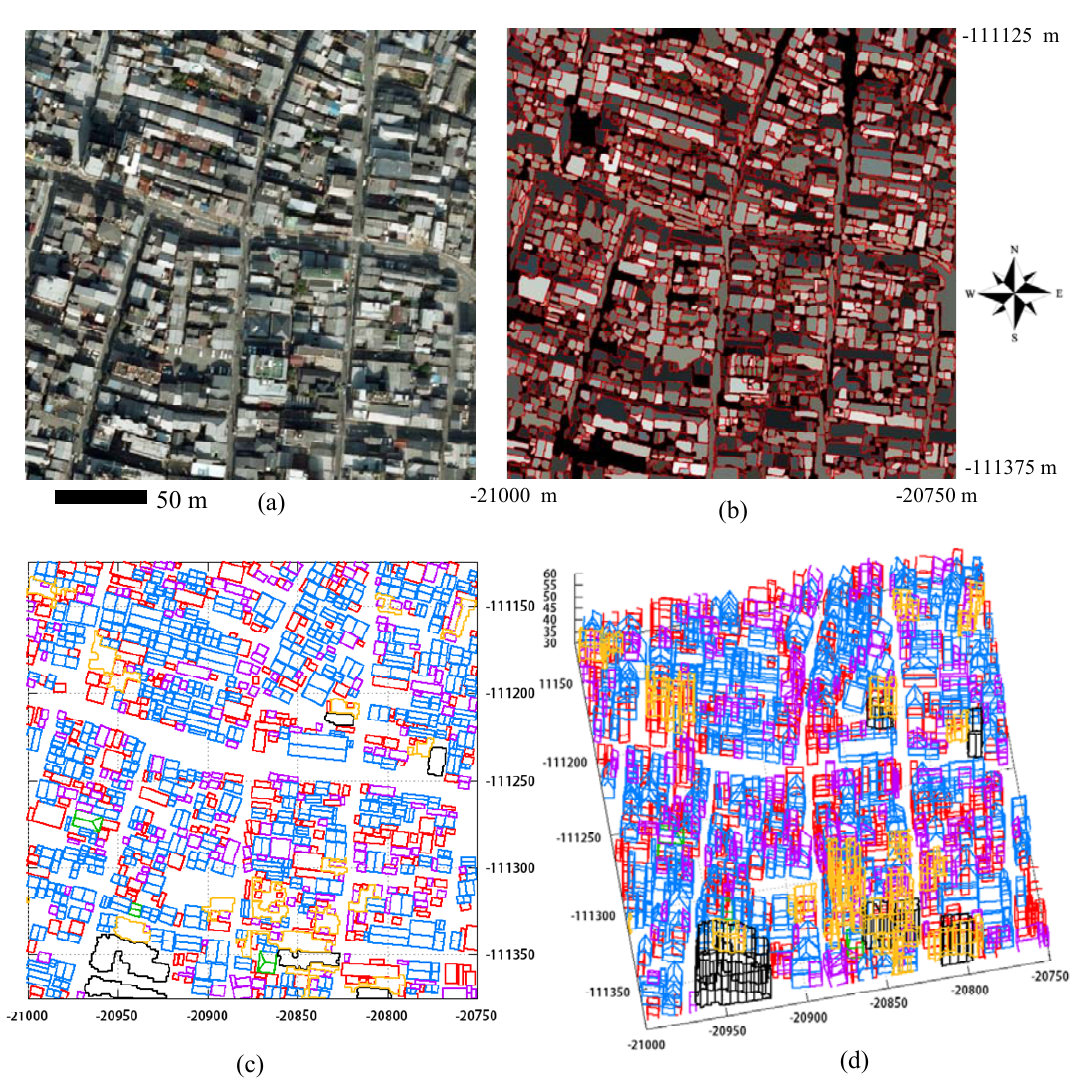
Figure 13. ( a ) Aerial image, ( b ) segmentation results, and ( c )( d ) modeling results for another area containing low-rise buildings. Wireframe models are as in Figure